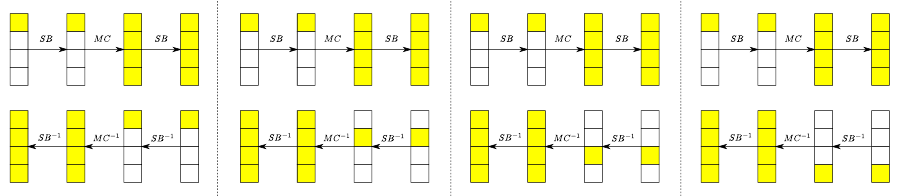
Figure 5: Four cases of DBCT of AES block cipher: DBCT 0 , 0 , DBCT 0 , 1 , DBCT 0 , 2 and DBCT 0 , 3